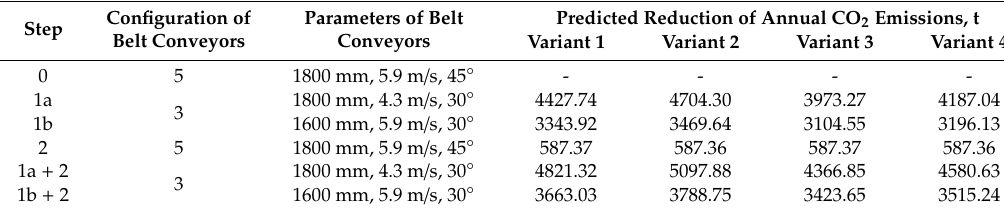
Table 5. Predicted reduction of annual CO 2